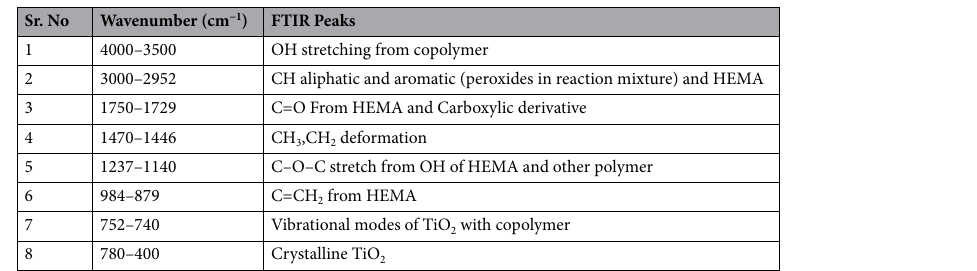
Table 3. FTIR description of